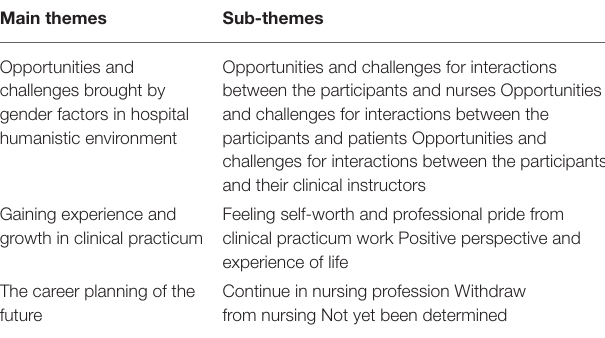
TABLE 3 | The interview guideline: open questions.